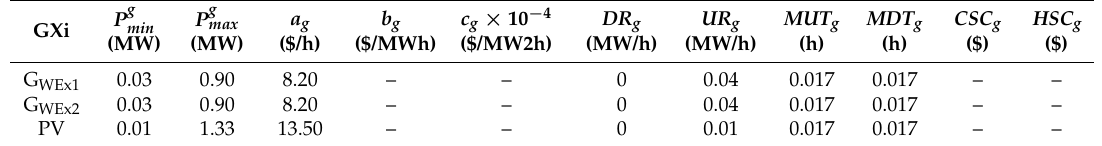
Table 2. Main Features of the Power System Expansion under Analysis.